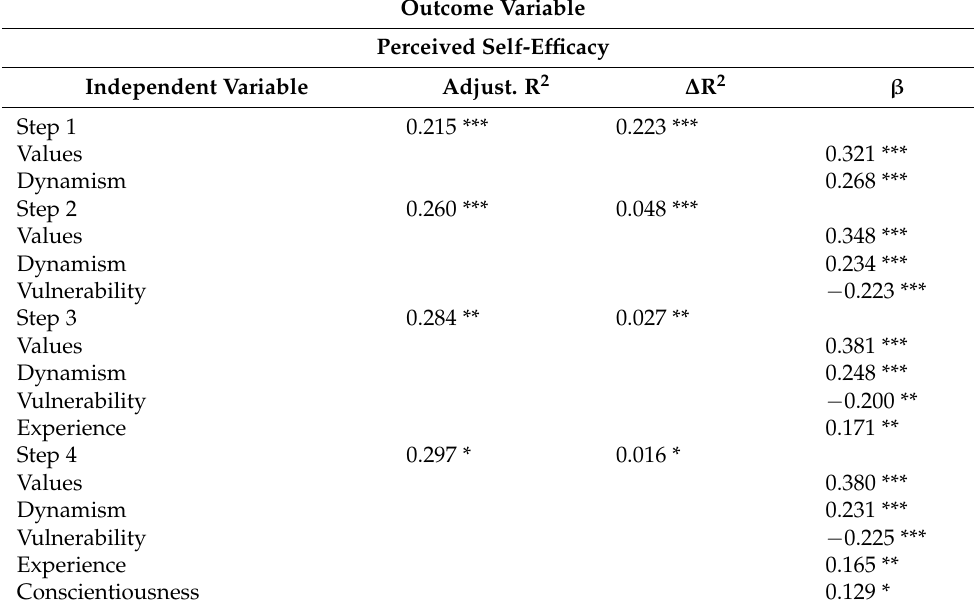
Table 5. Results of Hierarchical Linear Regression Analyses of Clown Therapists working with Children.